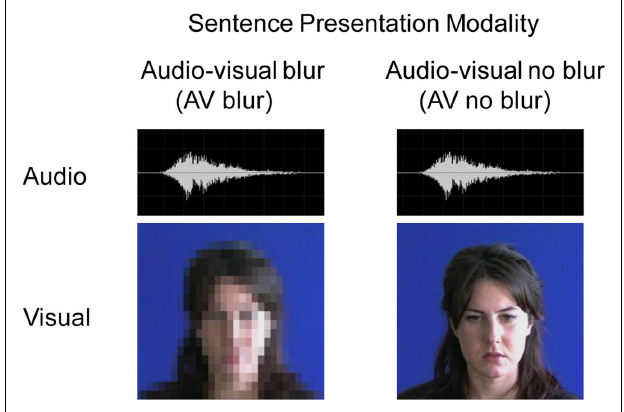
FIGURE 1 |A schematic illustration of the audio–visual stimuli used in our experiments. The images are static samples from the audio–video clips of a female actor articulating a sentence.The video information was either blurred through pixelation (left of figure) or not blurred (right of figure).The audio channel remained clear throughout both the “blur” and “no blur” presentation modalities.